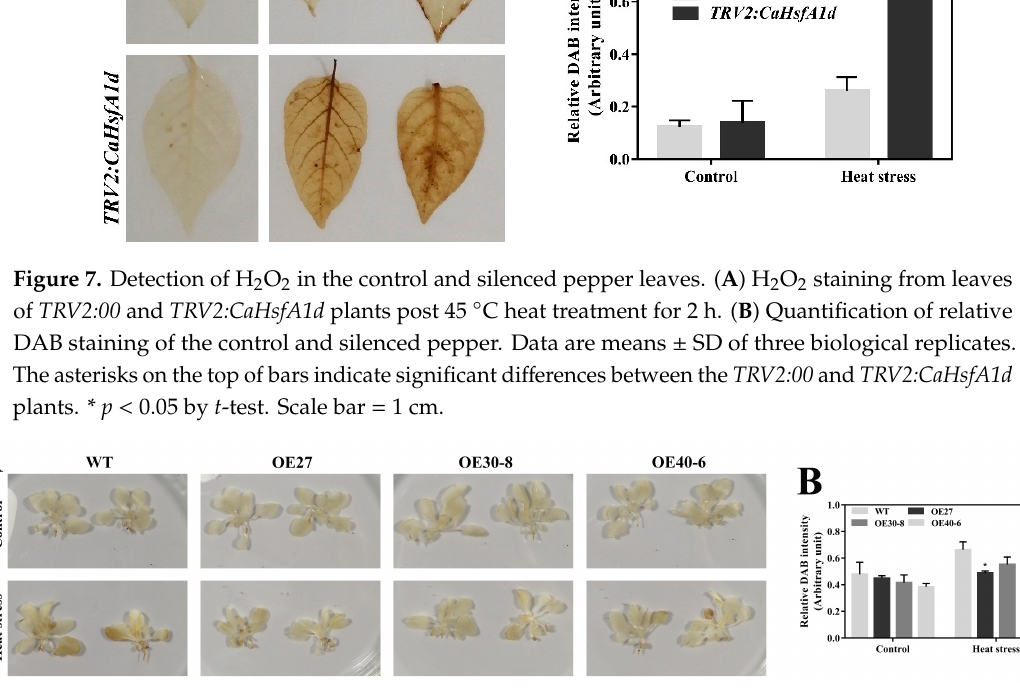
Figure 8. Detection of H 2 O 2 in the leaves of WT and overexpression Arabidopsis lines. ( A ) H 2 O 2 staining from the leaves of WT and transgenic plants post 37 ◦ C heat treatment for 2 h. ( B ) Quantification of relative DAB staining of the WT and CaHsfA1d -overexpression Arabidopsis . Data are means ± SD of three biological replicates. The asterisks on the top of bars indicate significant differences between WT and overexpressing lines. * p < 0.05 by t -test. Scale bar = 1 cm.